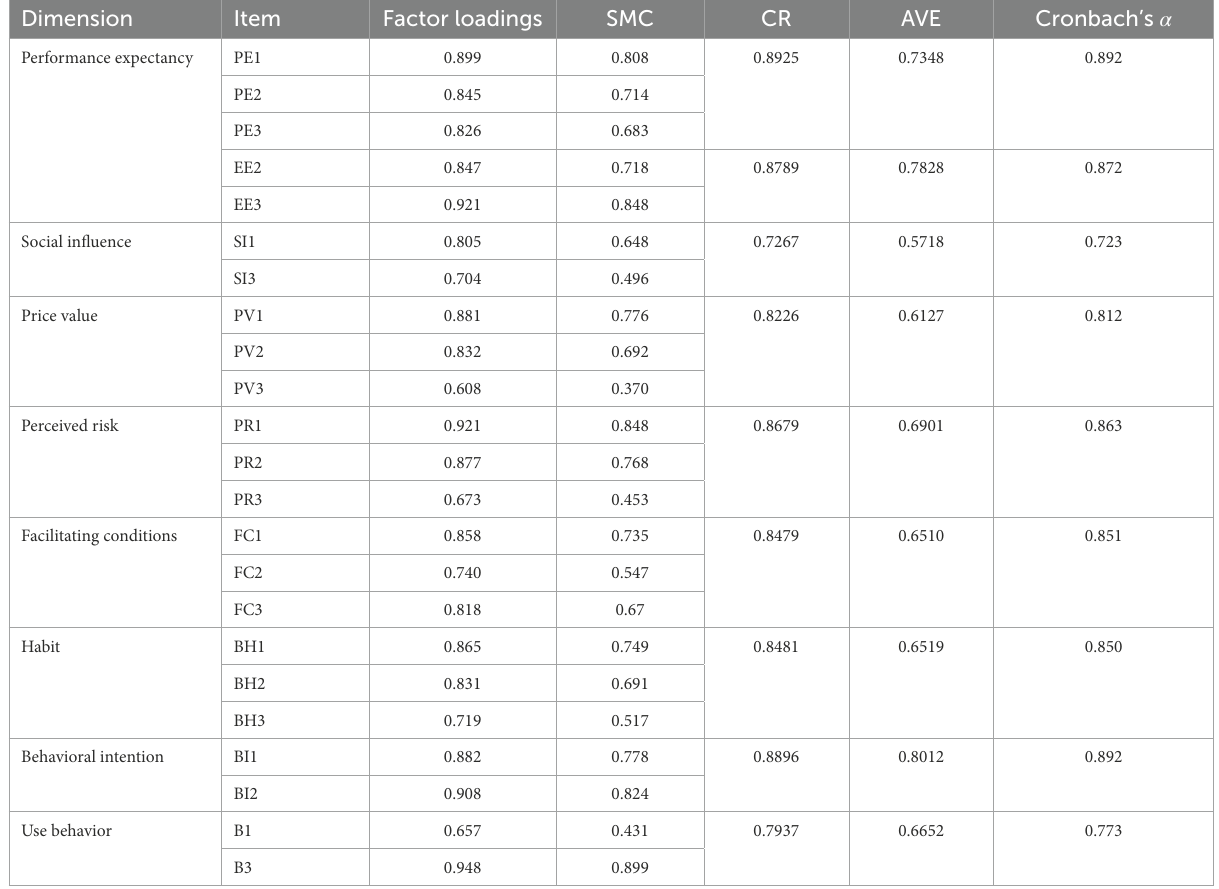
TABLE 2 Reliability and validity analysis results of questionnaire.